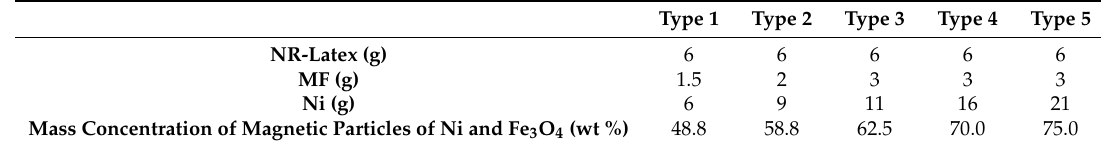
Table 1. Mass concentration of magnetic compound fluid (MCF) rubber liquid used in this study and ratios of mass concentration of magnetic particles and natural rubber